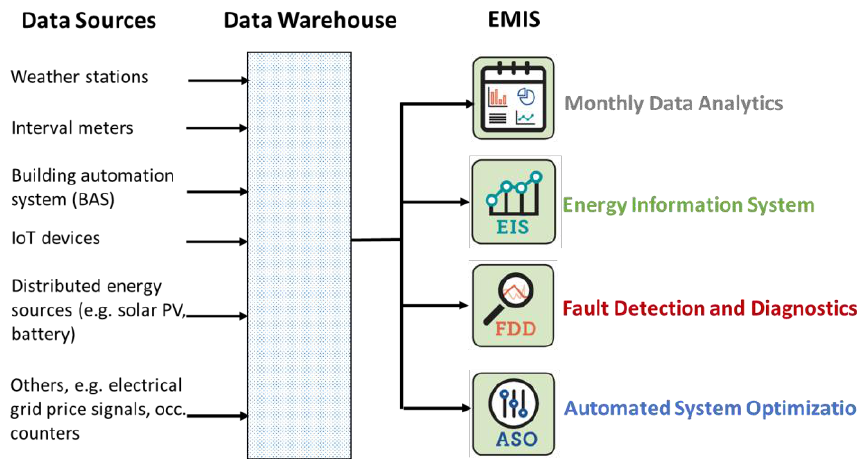
Figure 1. The family of Energy Management and Information Systems.